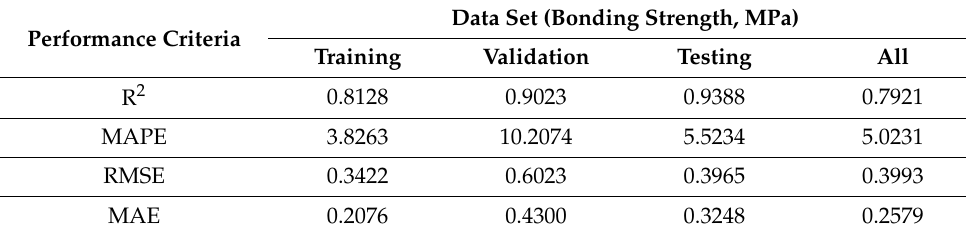
Table 5. Performance criteria used for predicting bonding strength by